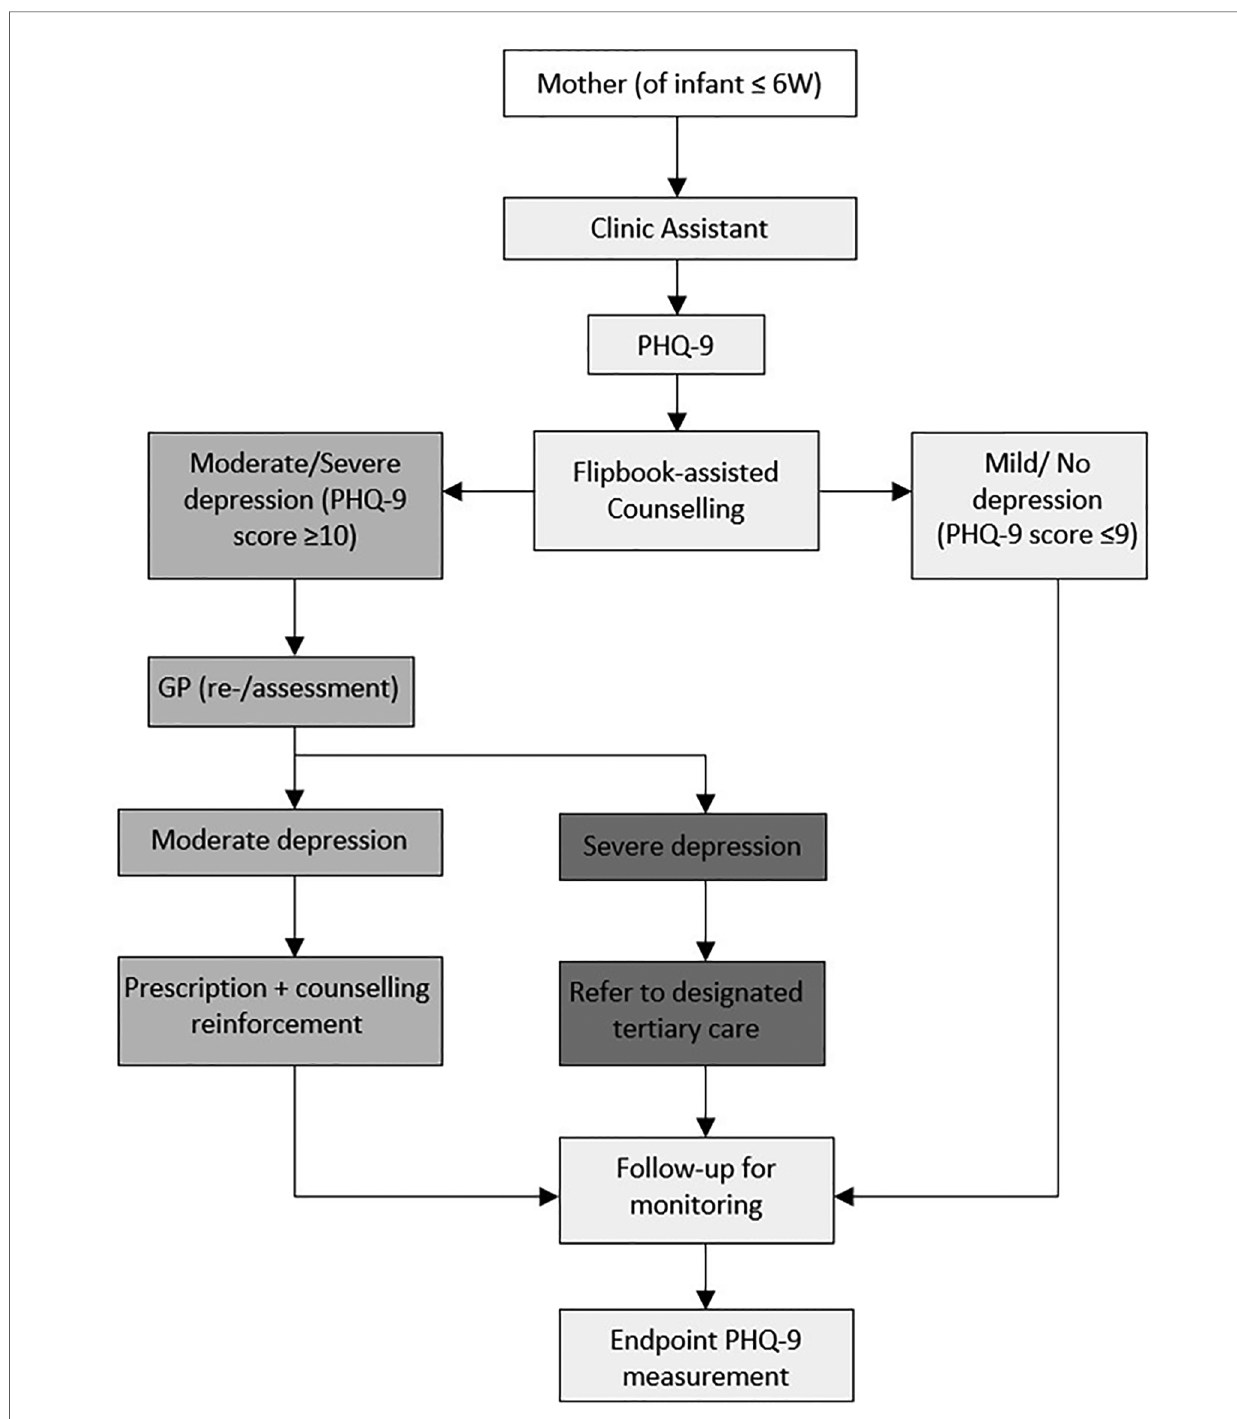
FIGURE 2 Depression intervention fl ow